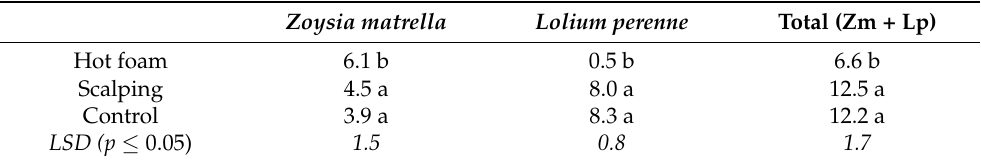
Table 9. Mean shoot density (no.cm − 2 ) for Zoysia matrella (Zm), Lolium perenne (Lp) and mean total shoot density for the association (Zm + Lp) as influenced by suppression method on 1 June 2021. Zoysia